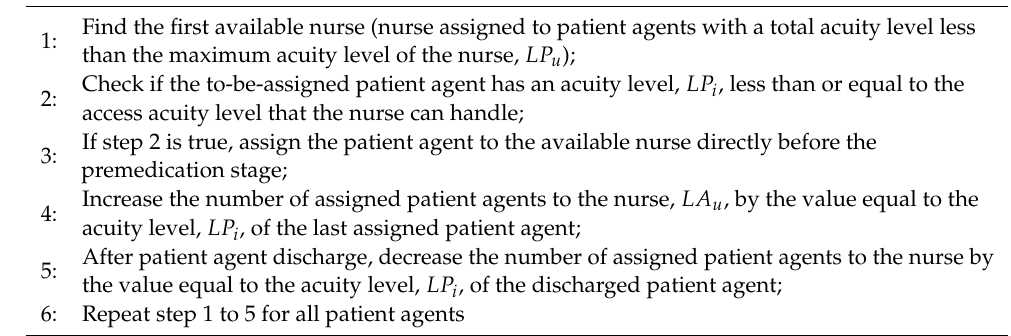
Algorithm 1 Simulating patient-to-nurse assignment based on acuity